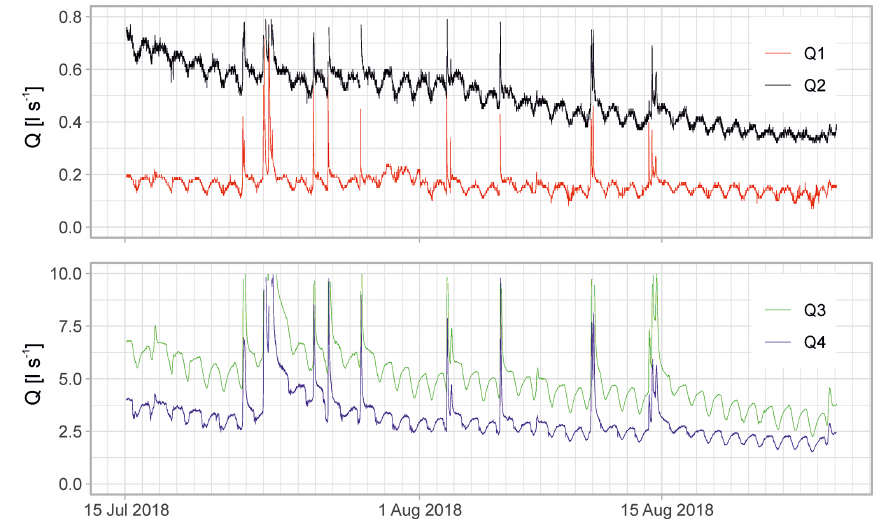
Figure 7. Diurnal fluctuations of flow for July/August 2018 (peak flows are cut off: Q1 and Q2 at 0.8Ls − 1 ; Q3 and Q4 at 10Ls − 1 ). Table 4. Statistics of precipitation data (statistics are calculated only if there are no missing values in the interval). NA – not available Site Time Percent Max daily Annual precipitation period missing precip. (mm) (mm)